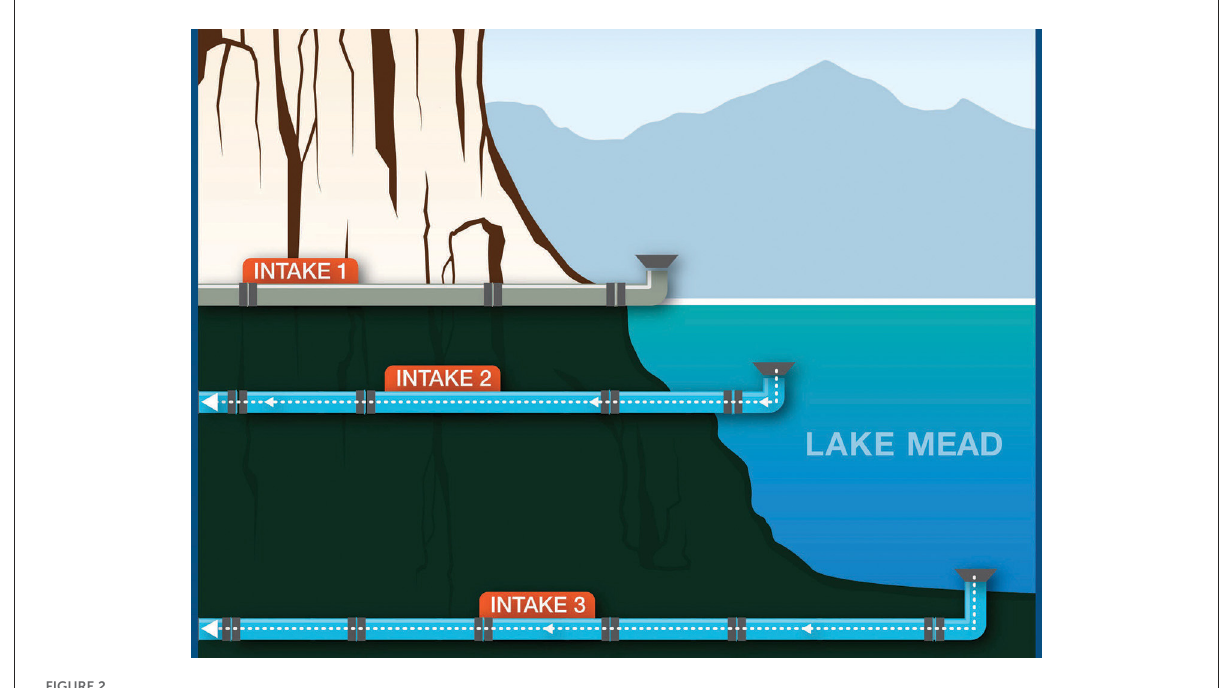
FIGURE2 Intake withdrawal